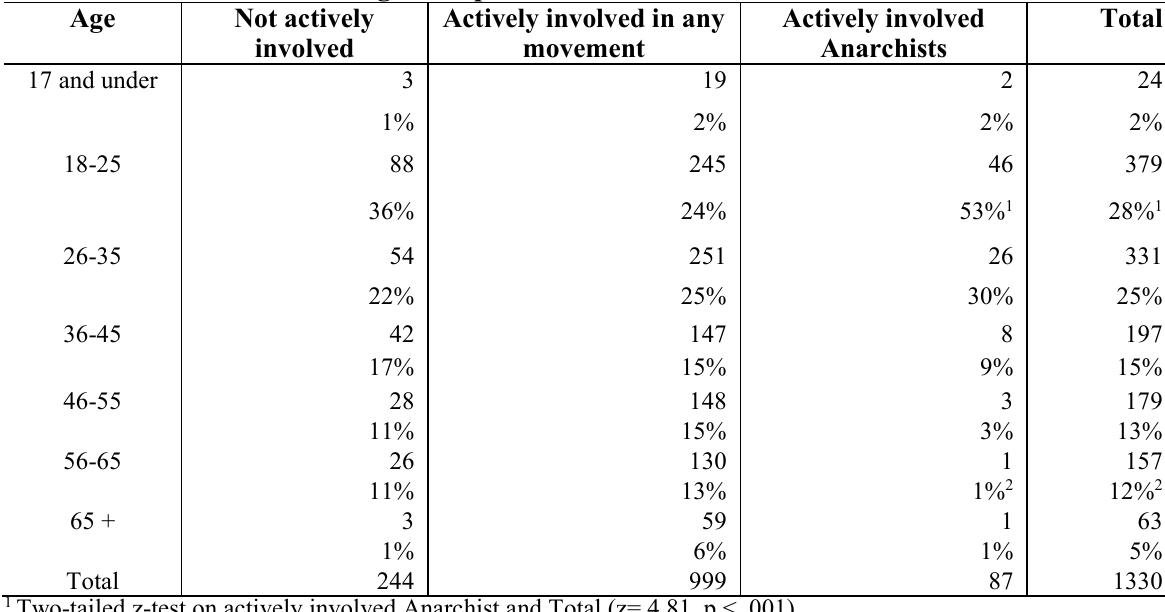
Total 244 999 87 1330 1 Two-tailed z-test on actively involved Anarchist and Total (z= 4.81, p < .001) 2 Two-tailed z-test on actively involved Anarchist and Total (z = -3.06, p < .01)